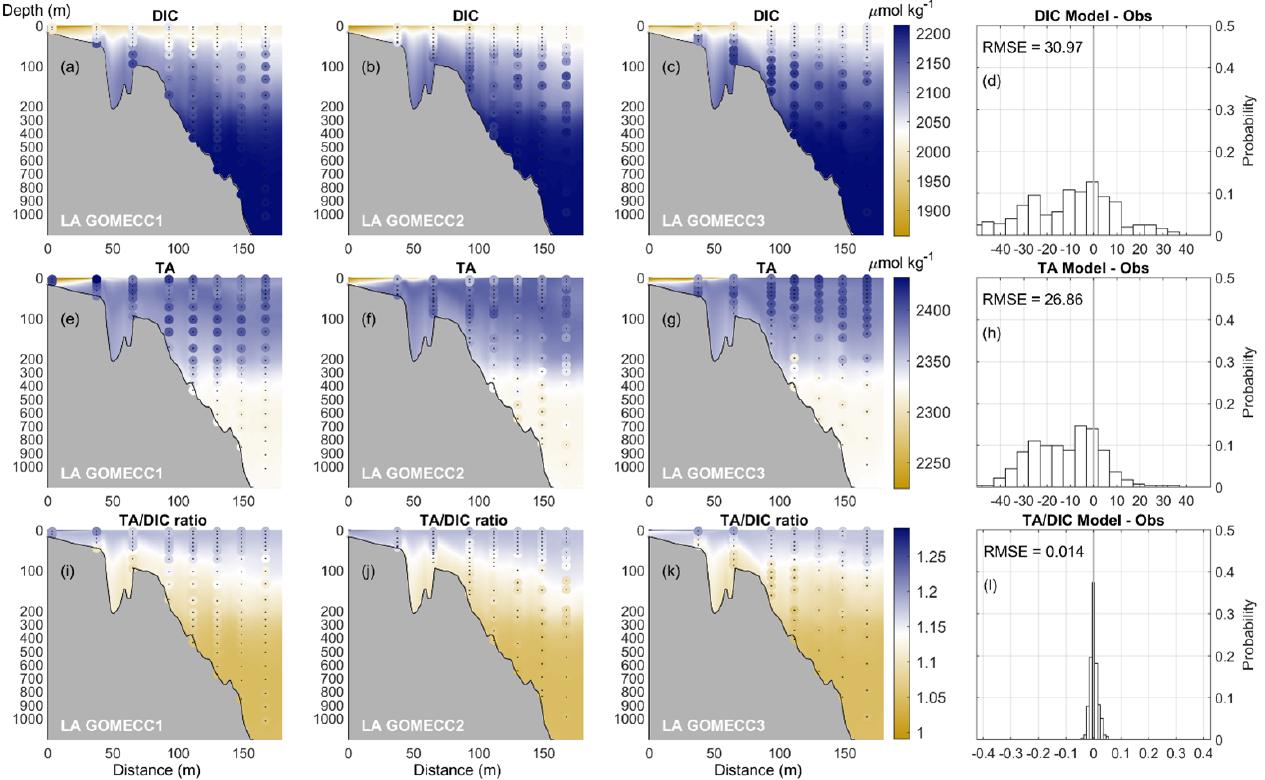
Figure 5. Discrete measurement of DIC and TA along the LA transect during GOMECC1, GOMECC2, and GOMECC3 cruises shown as oversized scattered dots (with the little black dots indicating their locations) compared with model results in color contour, with the water depth shown on the left side of each figure in meters. The distributions of model bias and RMSE for DIC, TA, and the TA / DIC ratio combining the three GOMECC cruises at the LA transect are shown in (d) , (h) , and (l) ,